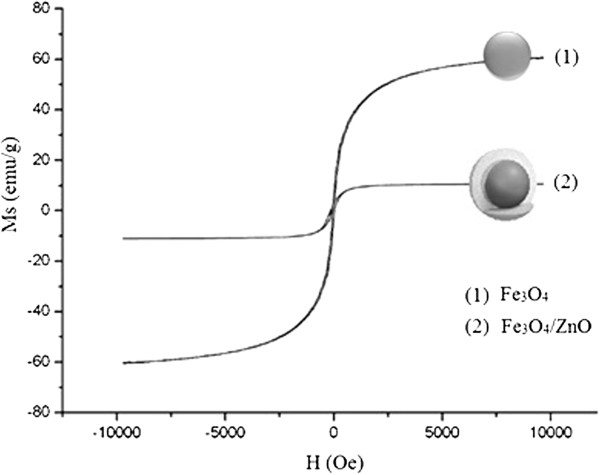
Magnetic hysteresis curves of (1): modified Fe3O4 (2): Fe3O4/ZnO core/shell.